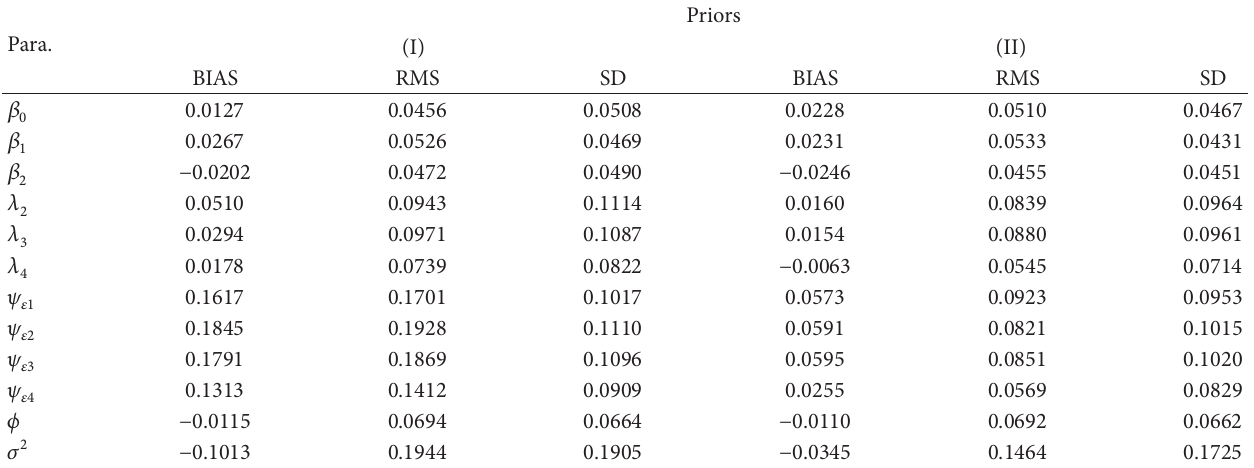
Table 2: Statistical results of Gibbs under prior (I) and prior (II) with relevant parameters. Para.